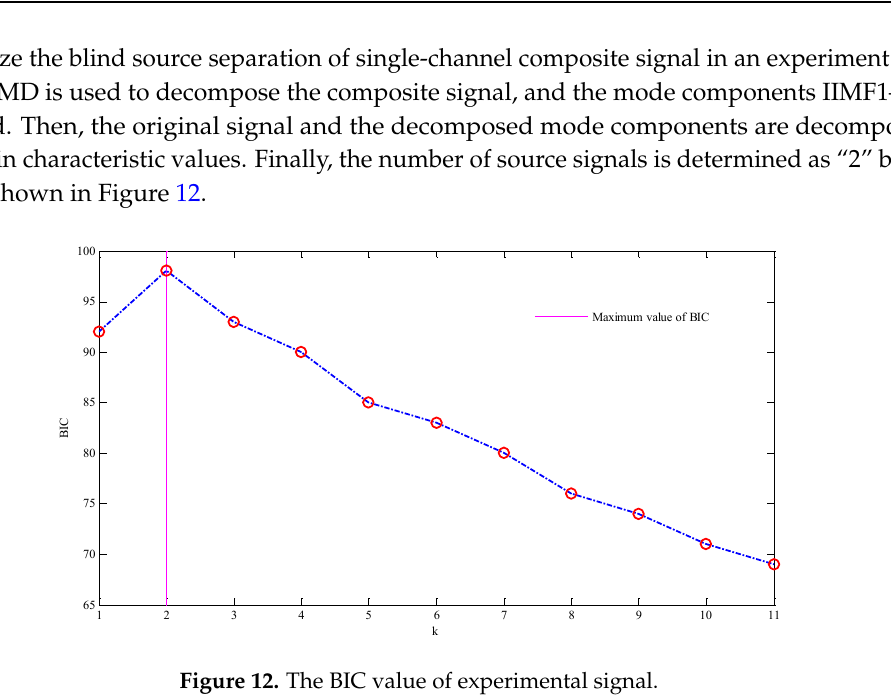
( b ) Figure 13. The response of measured vibrational signal: ( a ) collected composite original single channel signal in time-domain; and ( b ) collected composite original single channel signal in frequency-domain. In order to accurately evaluate the effectiveness of proposed method in this paper, the EMD-ICA and the conventional TSSA based on CP-ALS are used in the comparative study. The EMD is used to decompose the composite signal, and pluralities of IMFs are obtained. Then, two IMF S are chosen according to the maximum correlation coefficient between the IMFs and the composite signal, which can be regarded as the input data of ICA. The results are shown in Figure 14. We can make a conclusion that the recovered signals in frequency are both uncorrelated with fault frequency; therefore, the EMD-ICA is difficult to inspect the multiple faults characteristics.